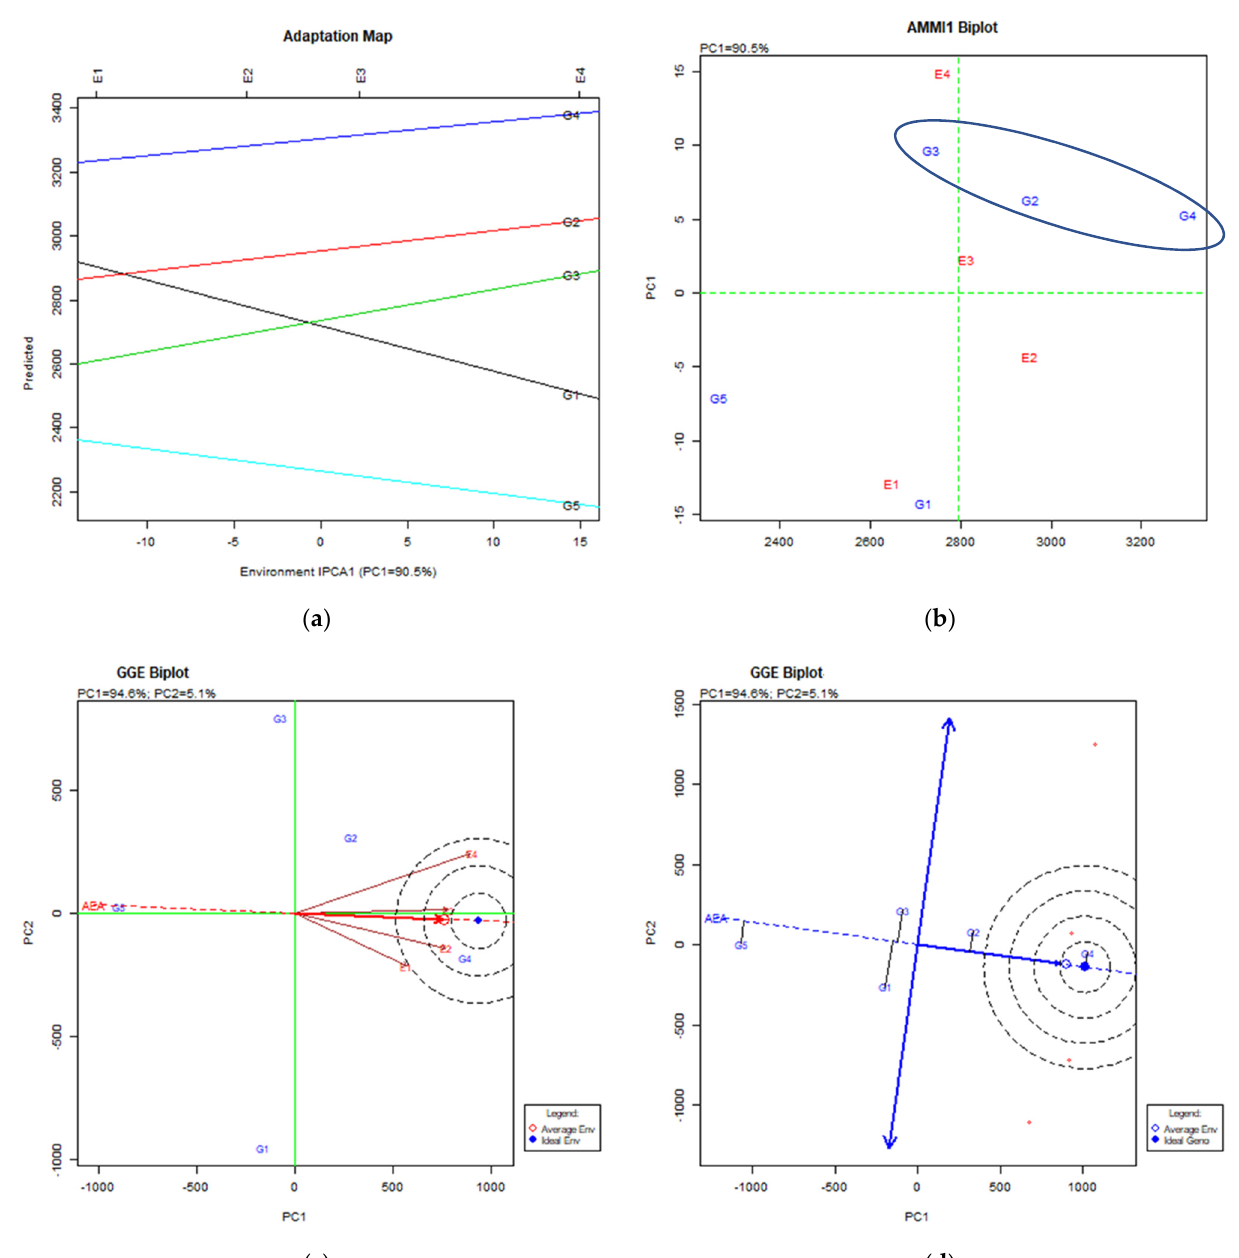
Figure 4. Stability analysis for seed yield (kg ha − 1 ) based on ( a ) the adaptation map where the X-axis (PC1) visualizes the stability of cultivars over environments and the Y-axis—the performance of cultivars for the trait; ( b ) the AMMI1 biplot where the Y-axis is the one visualizing the trait performance and the X-axis (PC1) visualizes the stability of cultivars over environments; ( c ) the GGE biplot for environments depicting the stability of the environments over years via the placement as near as possible to the ideal and average environment; ( d ) the GGE biplot for cultivars depicting the stability of the cultivars over environments where the productive cultivars are those to the right on the AEA vector and the stable ones are those which are as close to the AEA axis as possible.